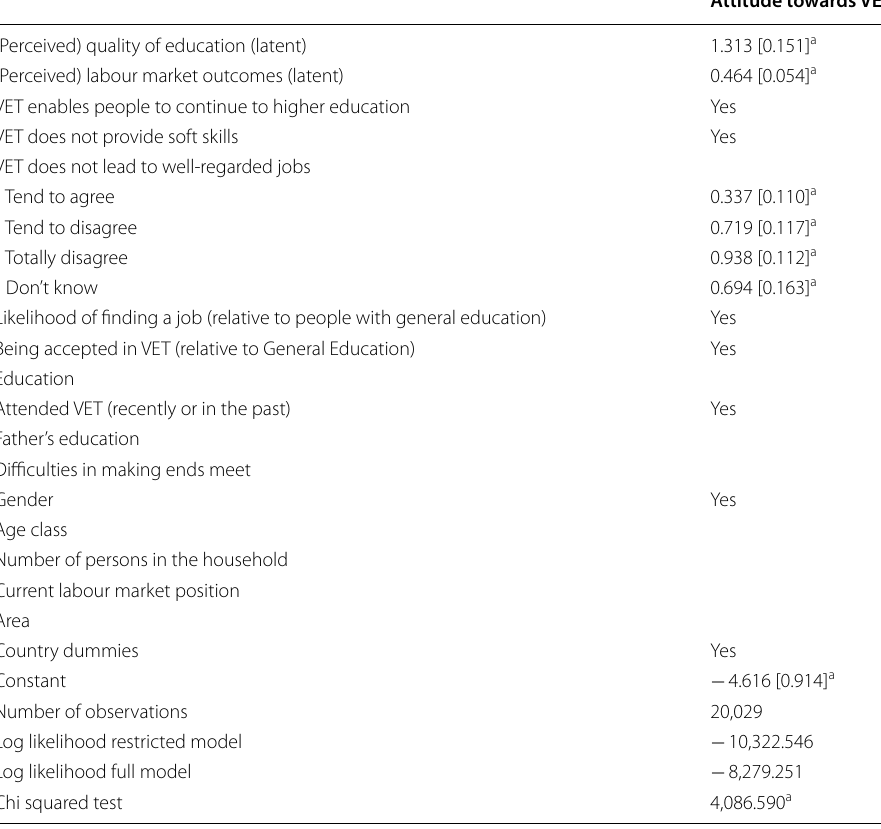
Table 3 Attitudes towards VET, weighted data (clustered standard error in